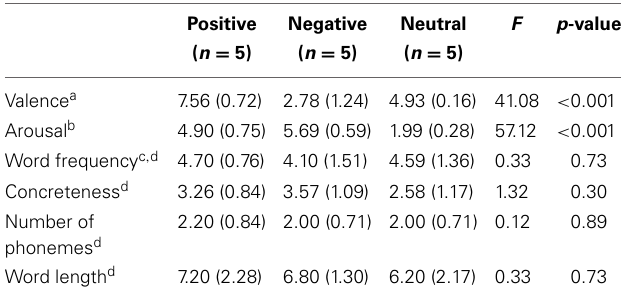
[mean (standard deviation)] and the results of an analysis of variance testing for differences between valence group